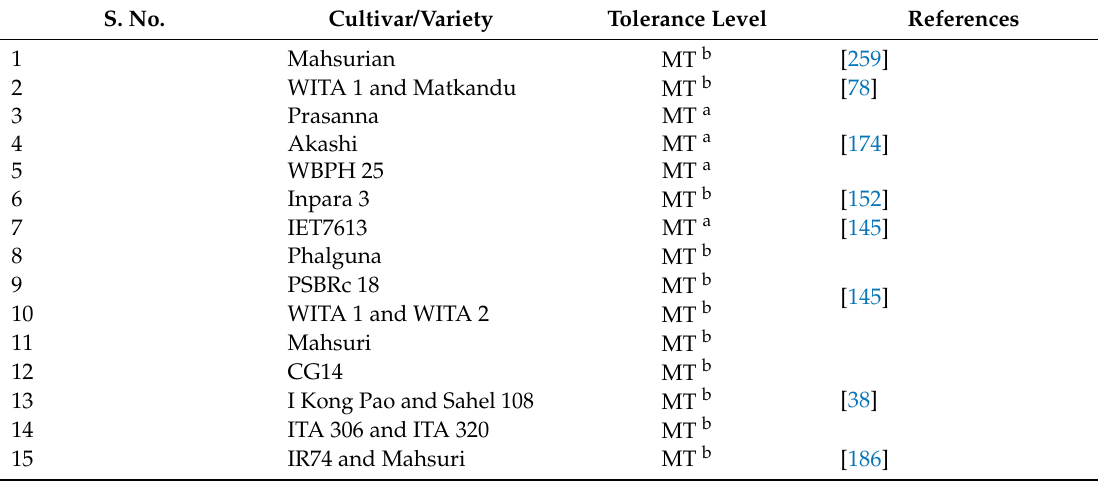
Table 5. List of genotypes identified for FT and FD moderately tolerant rice